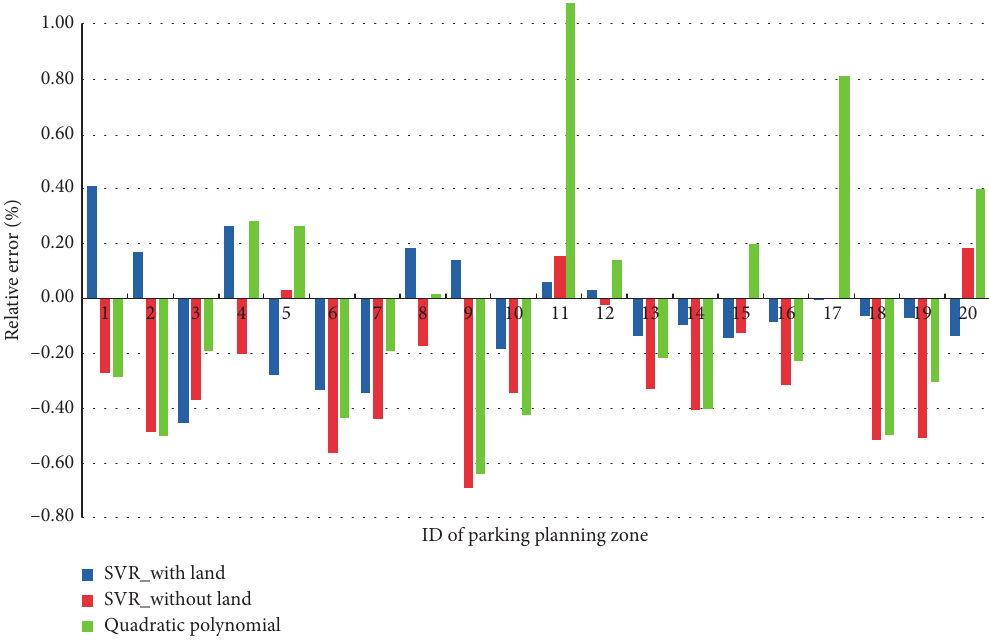
Figure 6: Bar graph of the estimation error distribution in each tested parking zone.